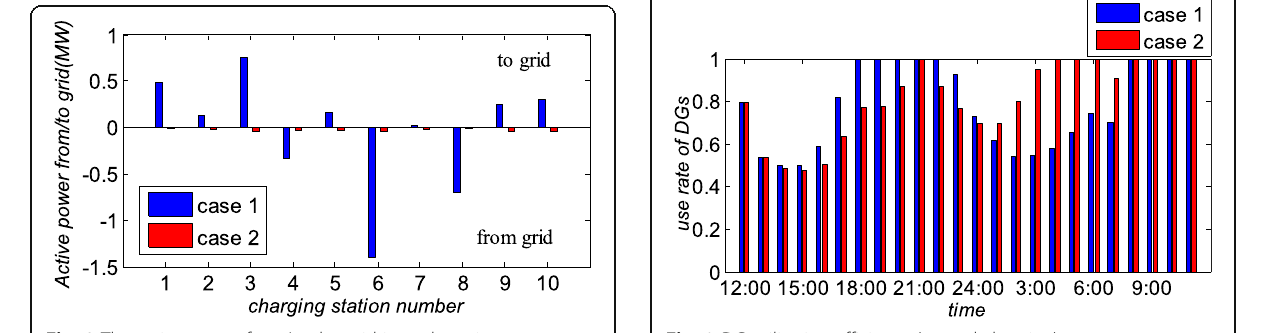
Fig. 8 The active power from/to the grid in each station